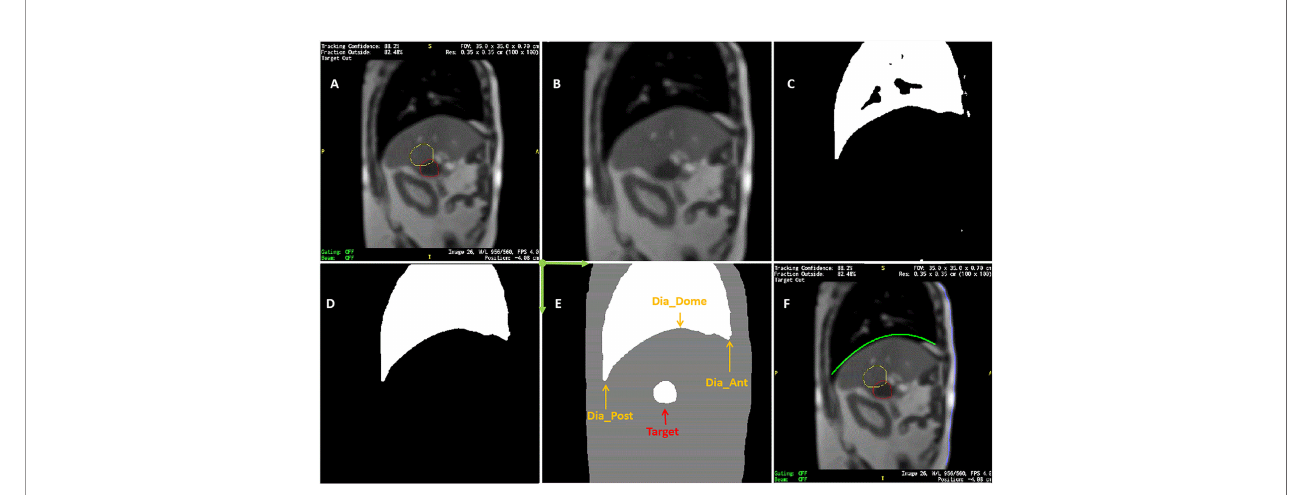
FIGURE 1 | Sample of MR image detection. (A) Acquired image. Yellow line contoured the expected target boundary and red line contoured the detected target. Every MR image frame had blank frame borders with information texts attached to four sides of MR images. (B) Cropped image after contours were removed. (C) Initially detected lung based on intensity threshold. (D) re fi ned lung structure. (E) Detected body, lung, and target contours superimposed. Dia_Dome, Dia_Post, Dia_Ant, are Target are labeled. Coordinate system origin locates at the upper-left corner and axis directions were illustrated in green arrows. (F) Detected body and diaphragmatic curve superimposed back to the original